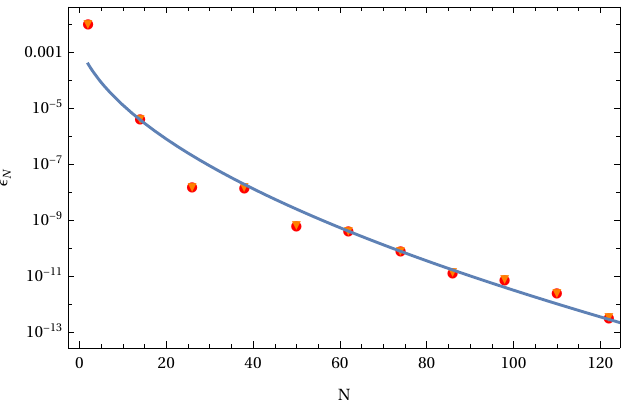
(cid:16) (cid:17) 1/2 − k . The least square fit delivered the 2 N